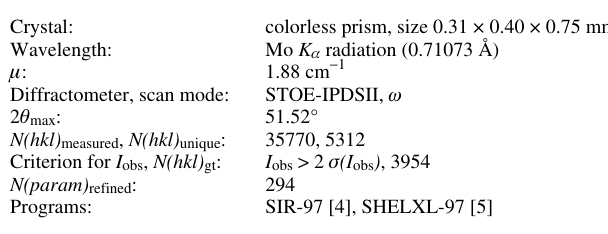
Table 1. Data collection and handling.